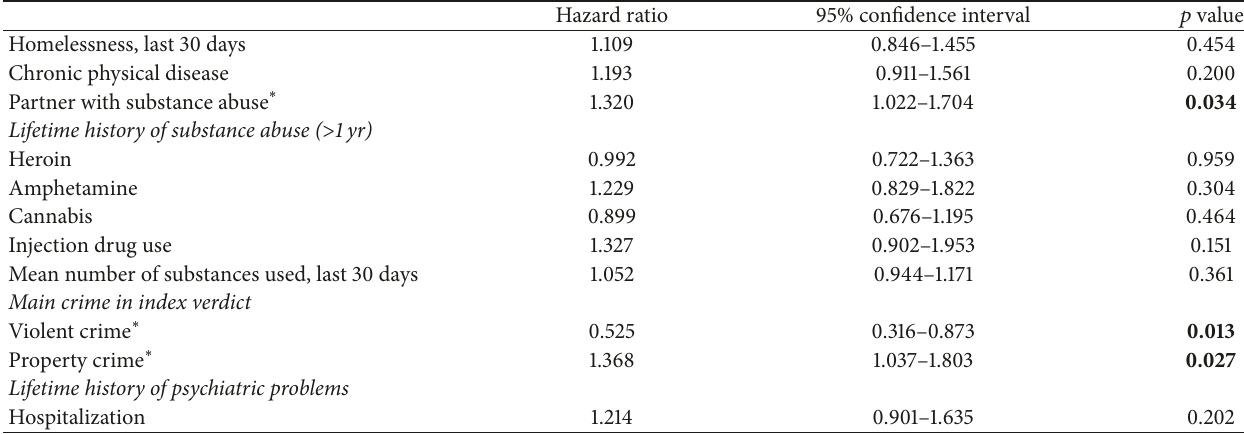
Table 5: Women: risk factors for criminal recidivism.